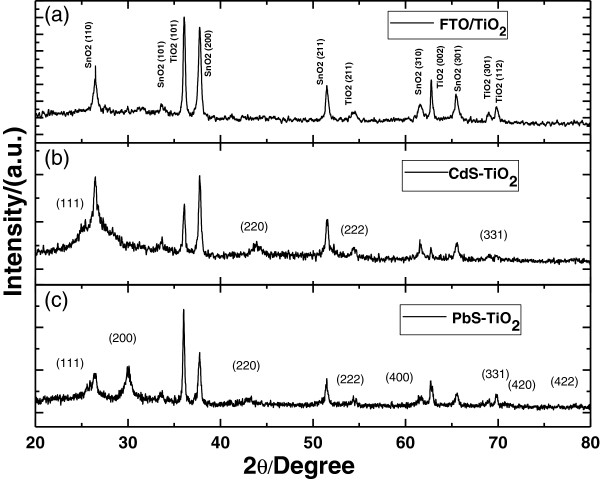
XRD patterns of bare TiO2nanorod array (a), CdS-TiO2nanostructure (b), and PbS-TiO2nanostructure (c).